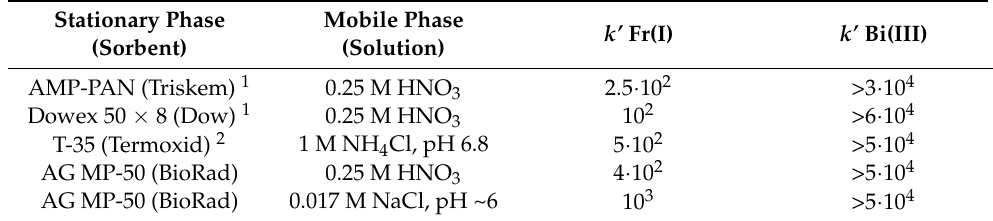
Table 1. Capacity factors k’ of Fr(I) and Bi(III) adsorbed onto various sorbents.